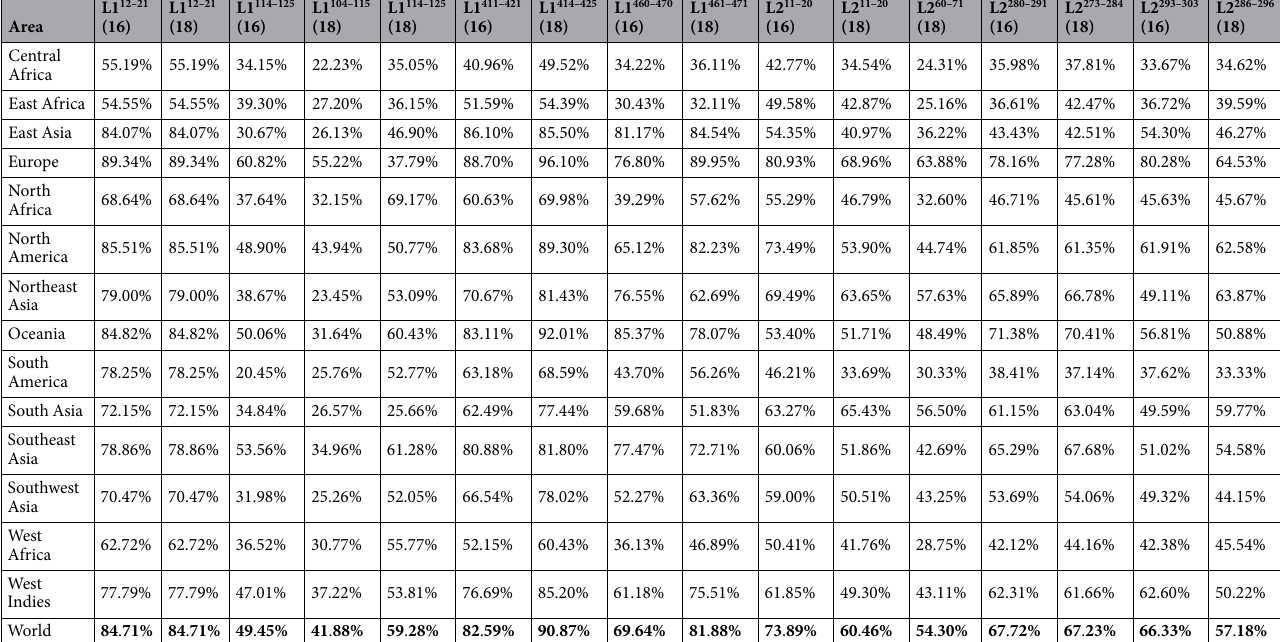
Table 9. Population coverage of putative HPV L1 and L2 CTL epitopes.